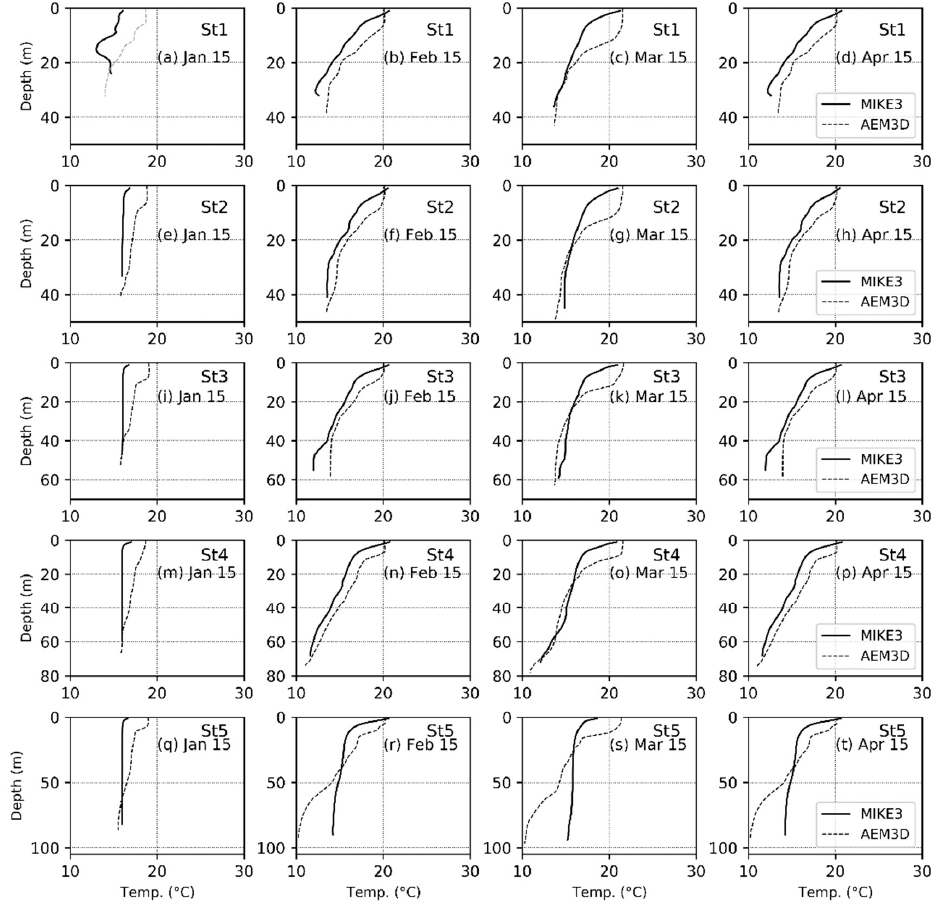
Figure 8. Comparison between MIKE3 (continuous lines) and AEM3D (dashed lines) water temperature profiles simulated at different times and different locations of the Maroon Reservoir.